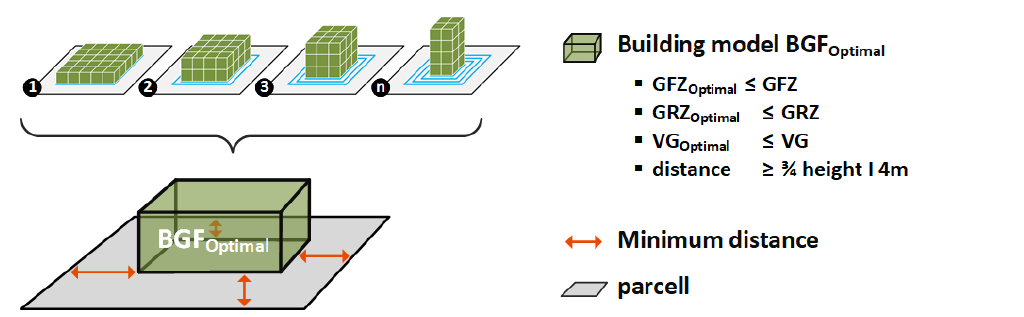
Figure 1. Schematic visualization of the optimal building model (Schneider & Gadocha